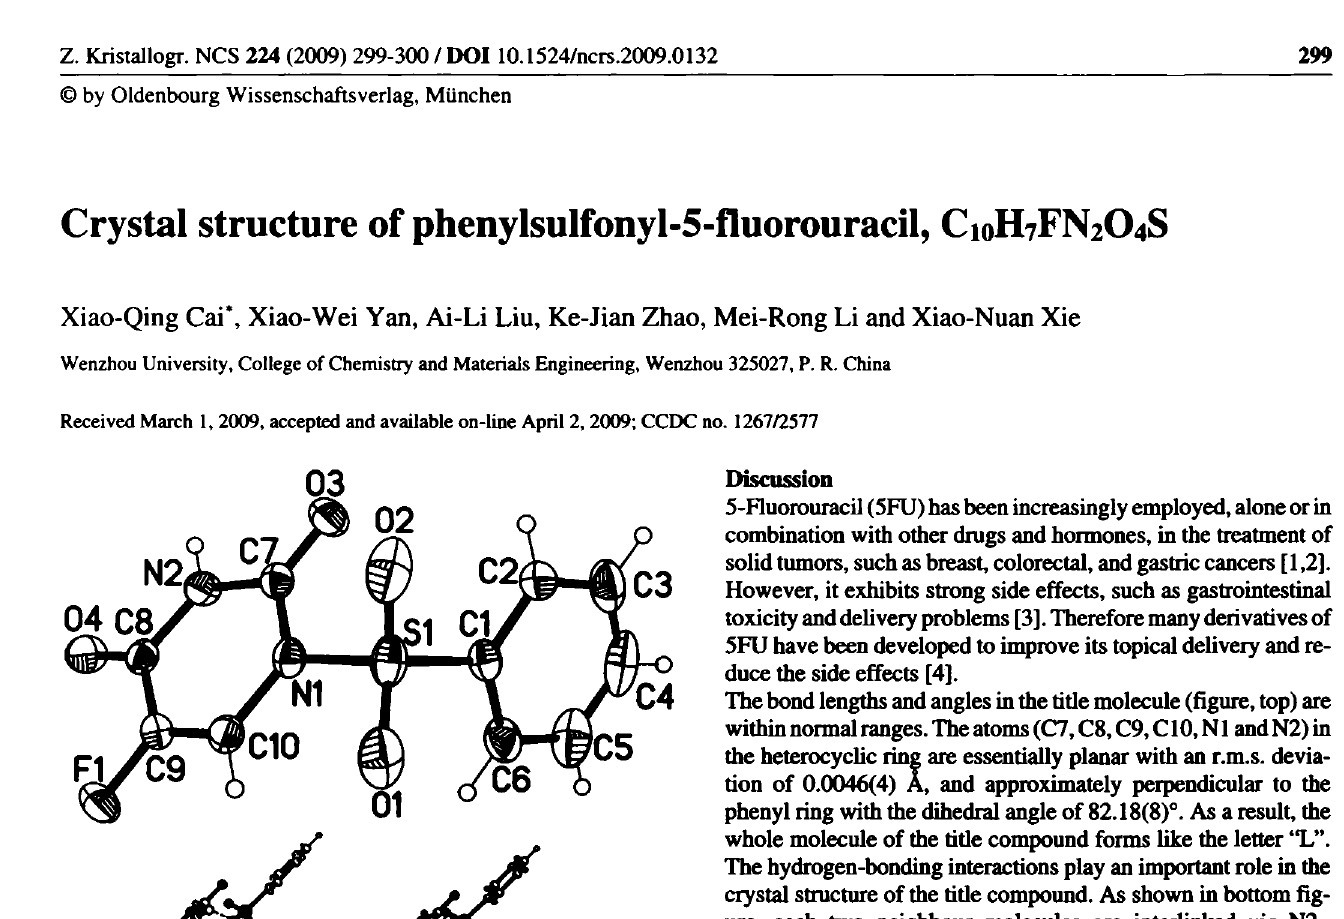
Table 1. Data collection and handling. Crystal: Wavelength: β· Diffractometer, scan mode: 20max • Nfhkljmasuad, N(hkl¡unique'· Criterion for /obs, N(hkl)